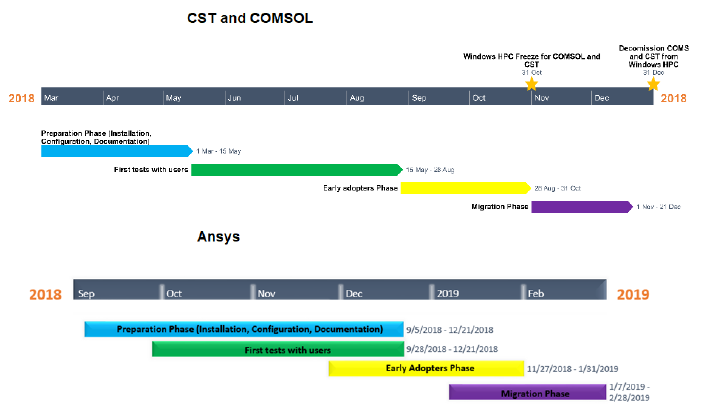
Figure 3. Migration